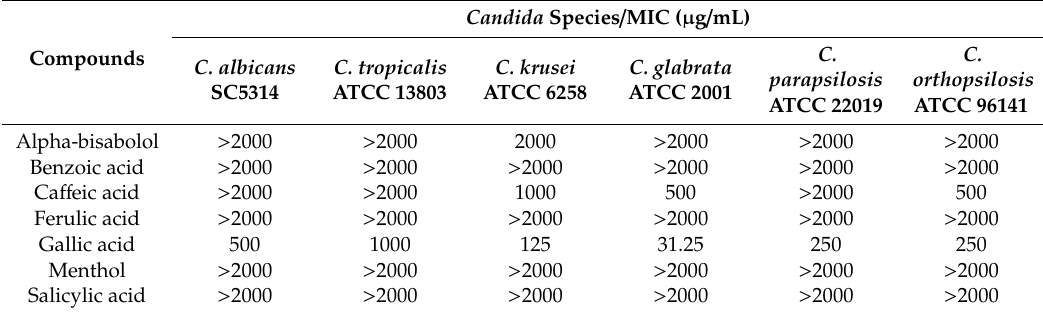
Table 3. Minimal inhibitory concentration (MIC) of plant-derived compounds against Candida species.